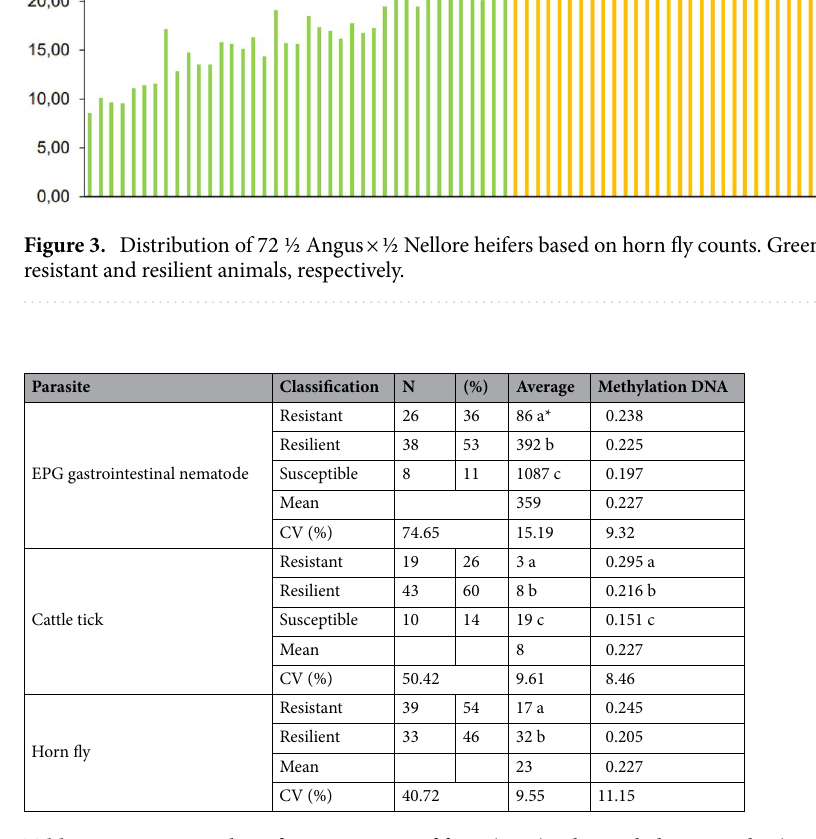
Table 1. Average number of eggs per gram of feces (EPG), Rhipicephalus microplus (cattle tick), Haematobia irritans (horn fly), global DNA methylation quantification (absolute absorbance value), and number of heifers per group (N) distributed into resistant, resilient, and susceptible groups, by Scott-Knott test (5%). *Different letters in the column show significant differences between groups by the Scott-Knott’s test ( p <